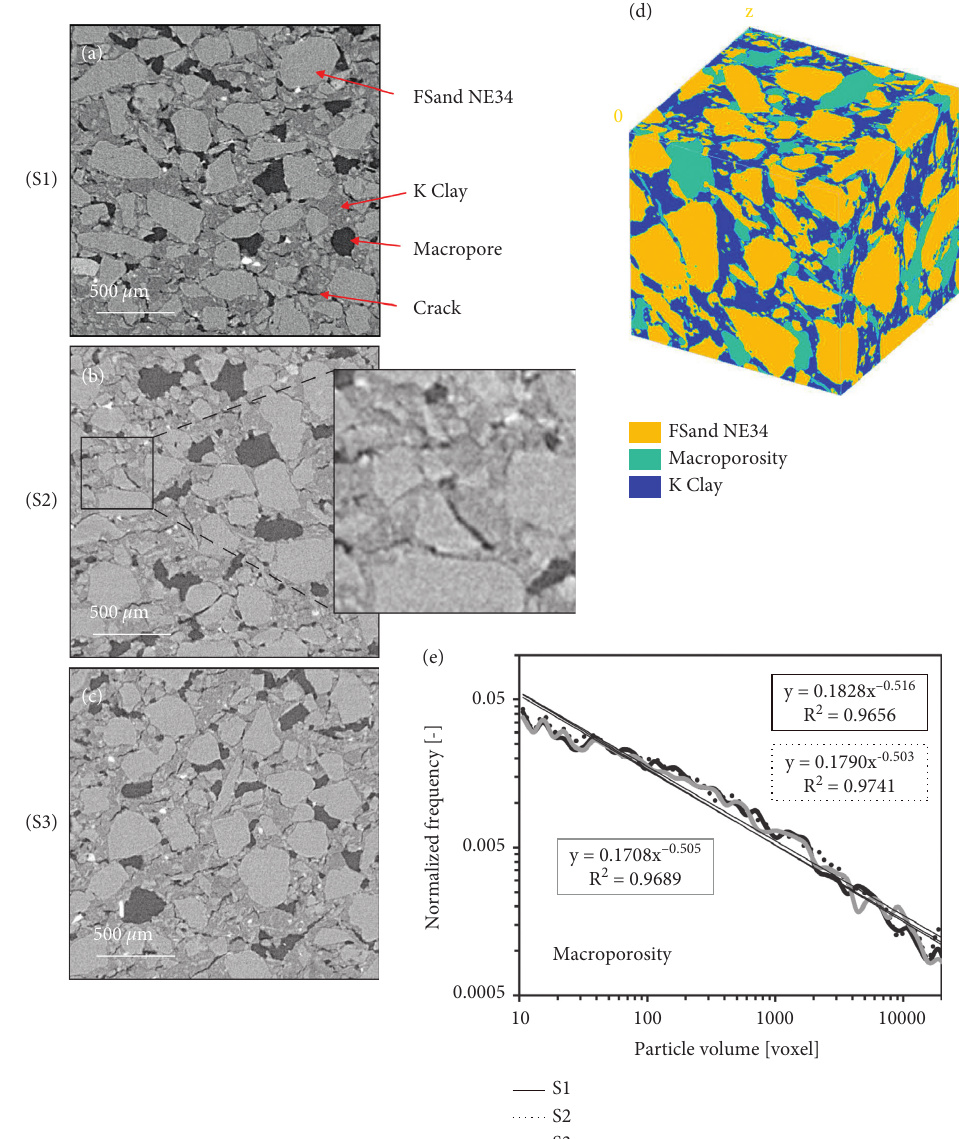
Figure 7: Mesostructures of (a) S1, (b) S2, (c) S3 samples under X-ray tomography; (d) image segmentation of FSand NE34, K Clay and macroporosity in an extract of an S3 sample; (e) macropore size distribution for the three samples prepared initially at 1.5 w L and after drying at 105 ° C.